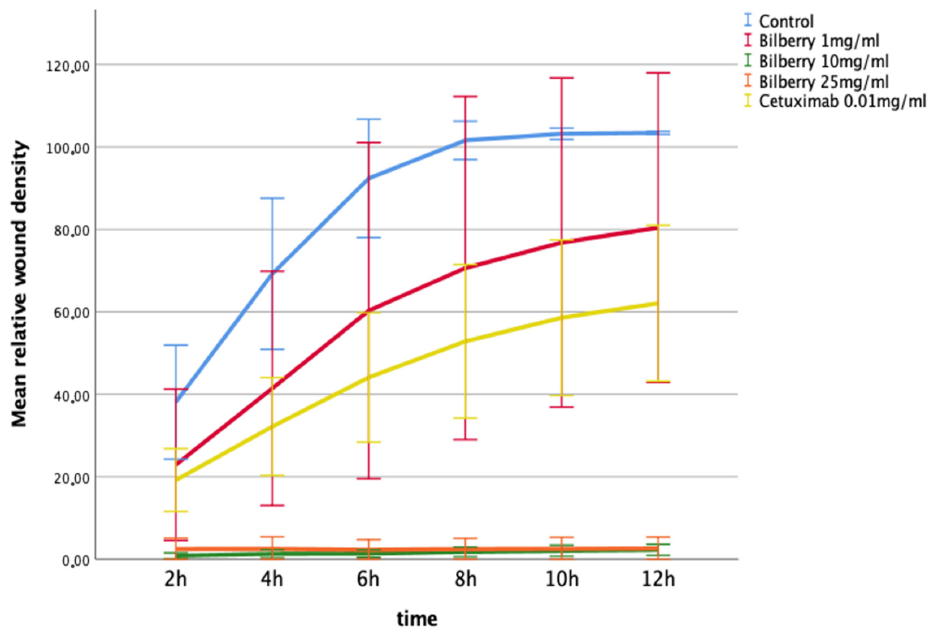
Figure 3. Migration of HSC-3 cells in Myogel after 12 h of bilberry powder and cetuximab incubations. Mean relative wound density and 95%CI error bars.